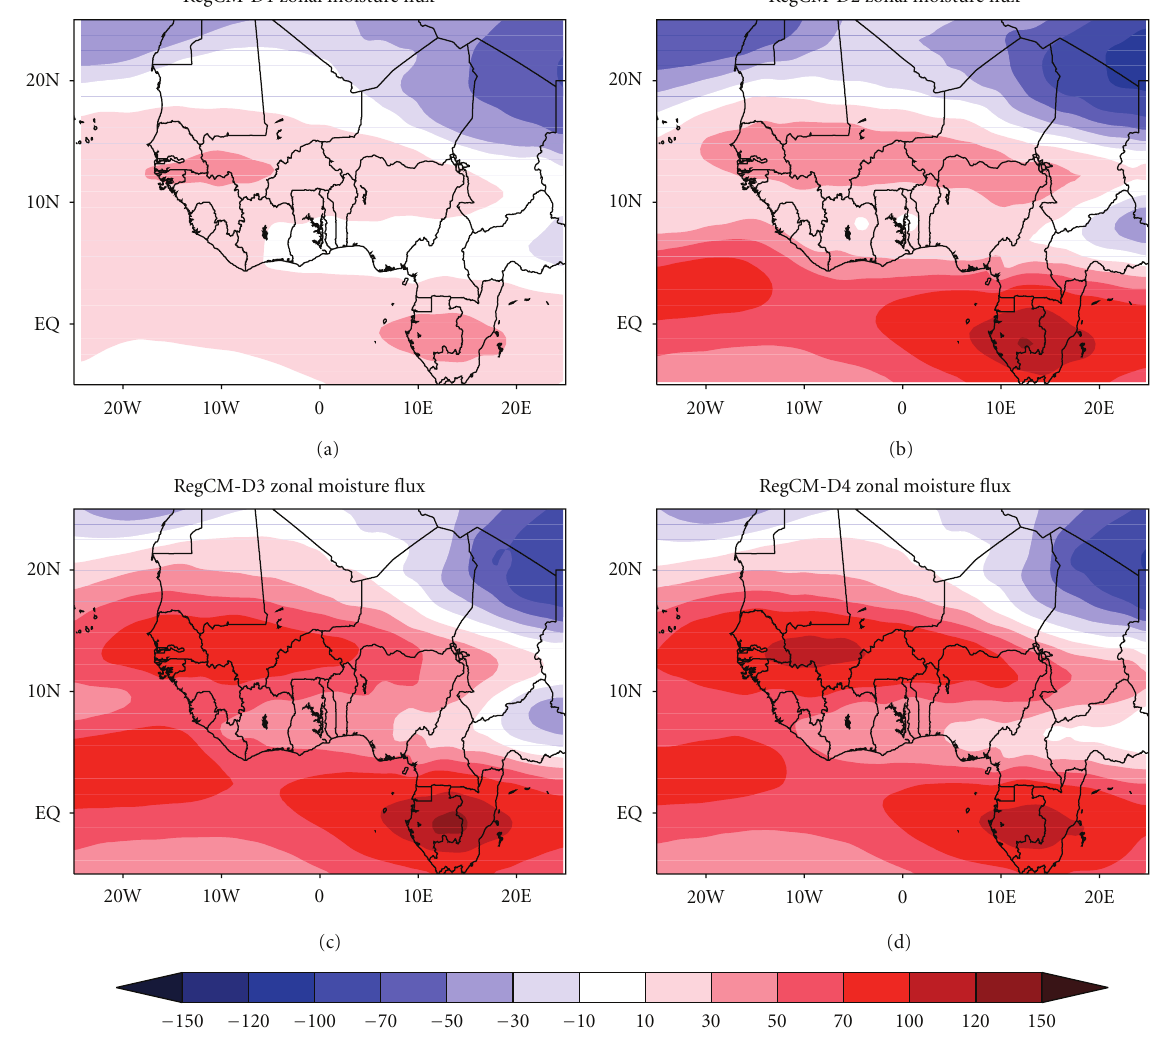
Figure 9: Mean JJA vertically integrated zonal moisture flux averaged for the period 2001–2005 for (a) RegCM-D1, (b) RegCM-D2, (c) RegCM-D3, and (d) RegCM-D4. Positive values denote westerly flow. Units are expressed in kg m − 1 s − 1